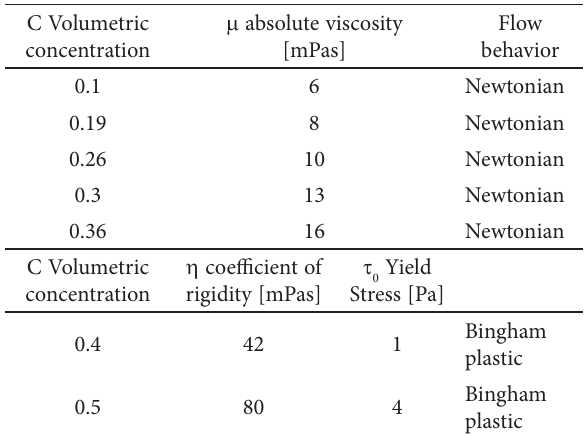
Table 6. Flow properties of Ashtech – India, Fly Ash